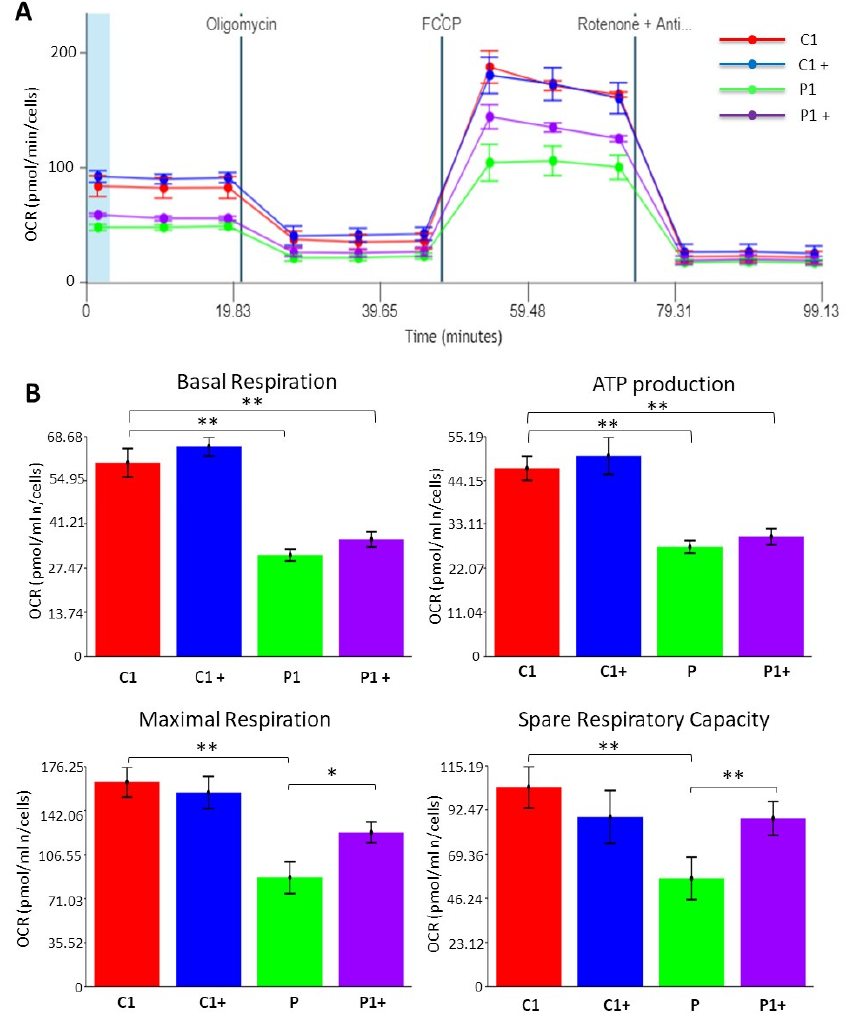
Figure 6. Pantothenate and L ‐ carnitine supplementation improves cell bioenergetics of mutant KAT6A fibroblasts (P1). Control (C) and KAT6A fibroblasts (P1) were treated for 15 days with 0.7 μ M pantothenate and 0.7 μ M L ‐ carnitine (C+ and P1+). ( A ) Mitochondrial respiration profile was measured with a Seahorse XFe24 analyzer. Fibroblasts were treated for 15 days with 0.7 μ M panto ‐ thenate and 0.7 μ M L ‐ carnitine. ( B ) Basal respiration, ATP production, maximal respiration, and spare respiratory capacity were assessed by the Seahorse analytics website. * p ‐ value < 0.05 and ** p ‐ value < 0.01.